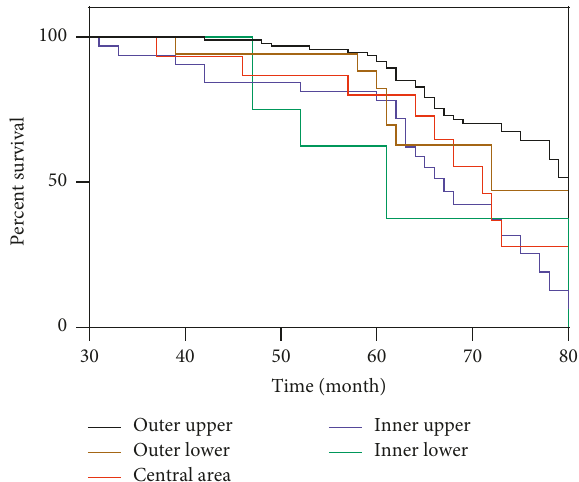
Figure 1: Prognostic survival curves of IDC patients with different tumor locations after modified radical